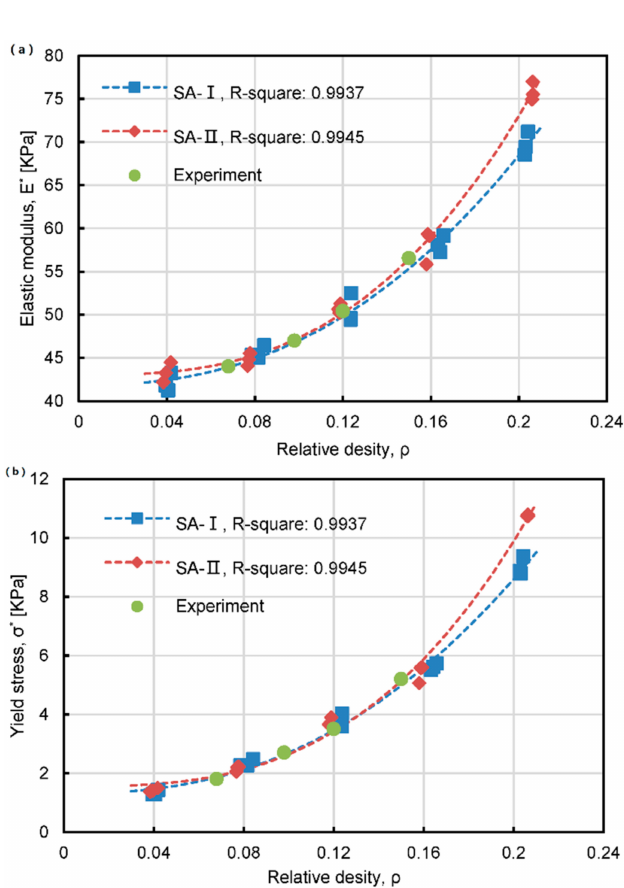
Figure 6. Power law of elastic modulus ( a ) and yield stress ( b ) for the SA-I and SA-II structures. SA-I has a Gaussian distribution of pore sizes and ligament diameters; SA-II has a constant pore size and ligament